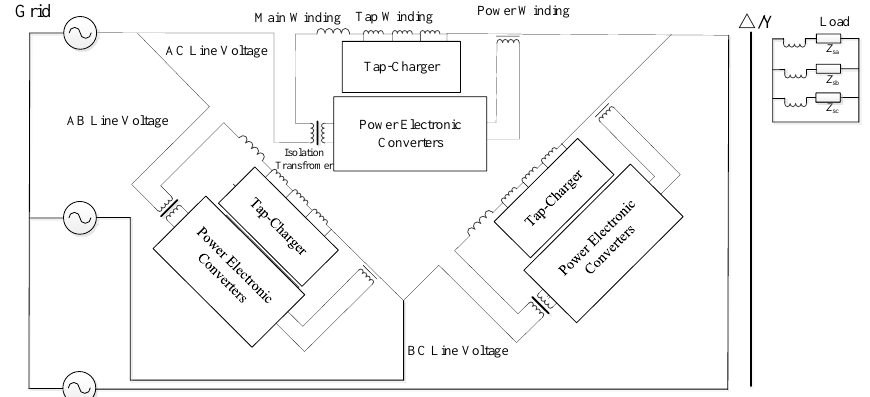
Figure 1. Topology structure of flexible on-load voltage regulator.